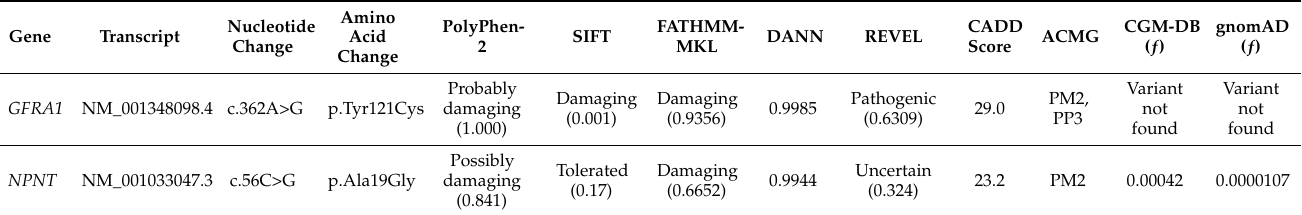
Table 1. In silico tool predictions of detected missense variants in GFRA1 and NPNT